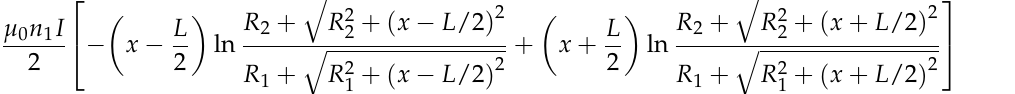
Figure 3. The diagram of the sensor. Generally, inductive sensors are composed of multiple layers of solenoids. The central axis of the solenoid is set as the origin. The magnetic field at any point on the axis of the multi-layer solenoid is represented as